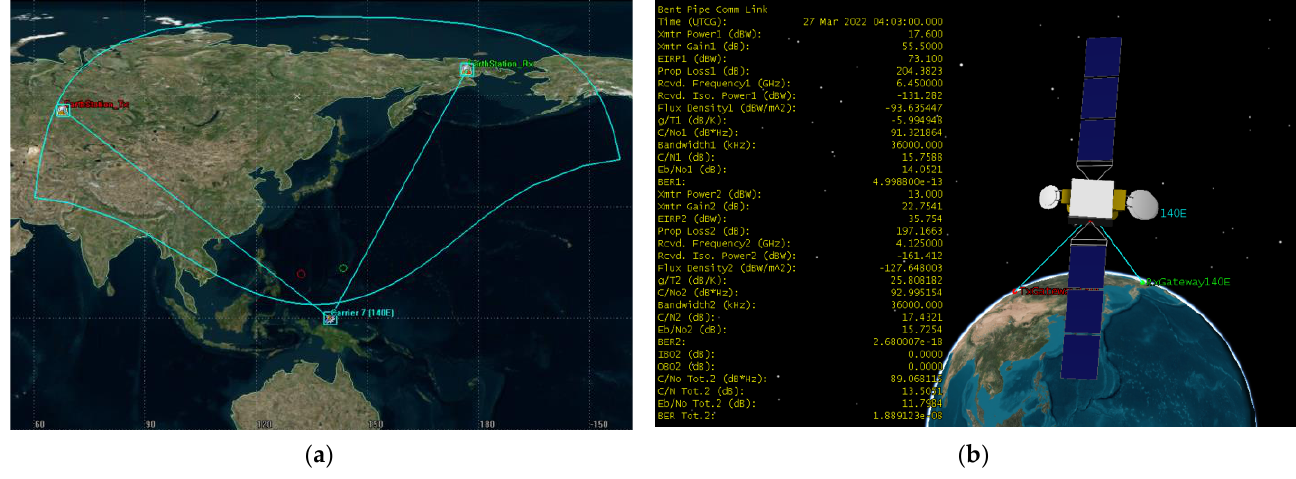
Figure 8. Scenario 1 operation ( a ) 140° E bent pipe transponder operation ( b ) Bent piper of Express 140E transponder composite link calculation.